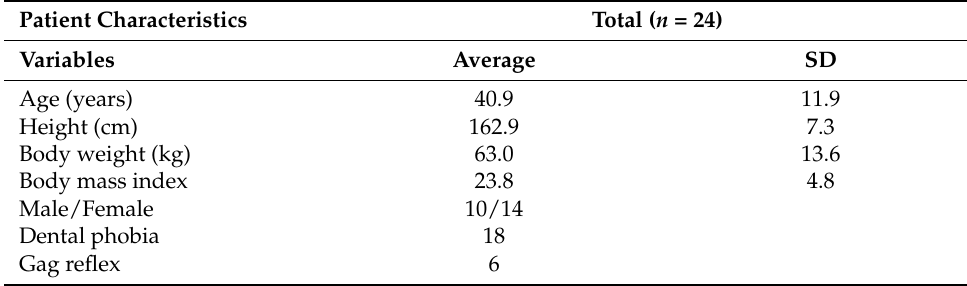
Table 1. Patient demographic